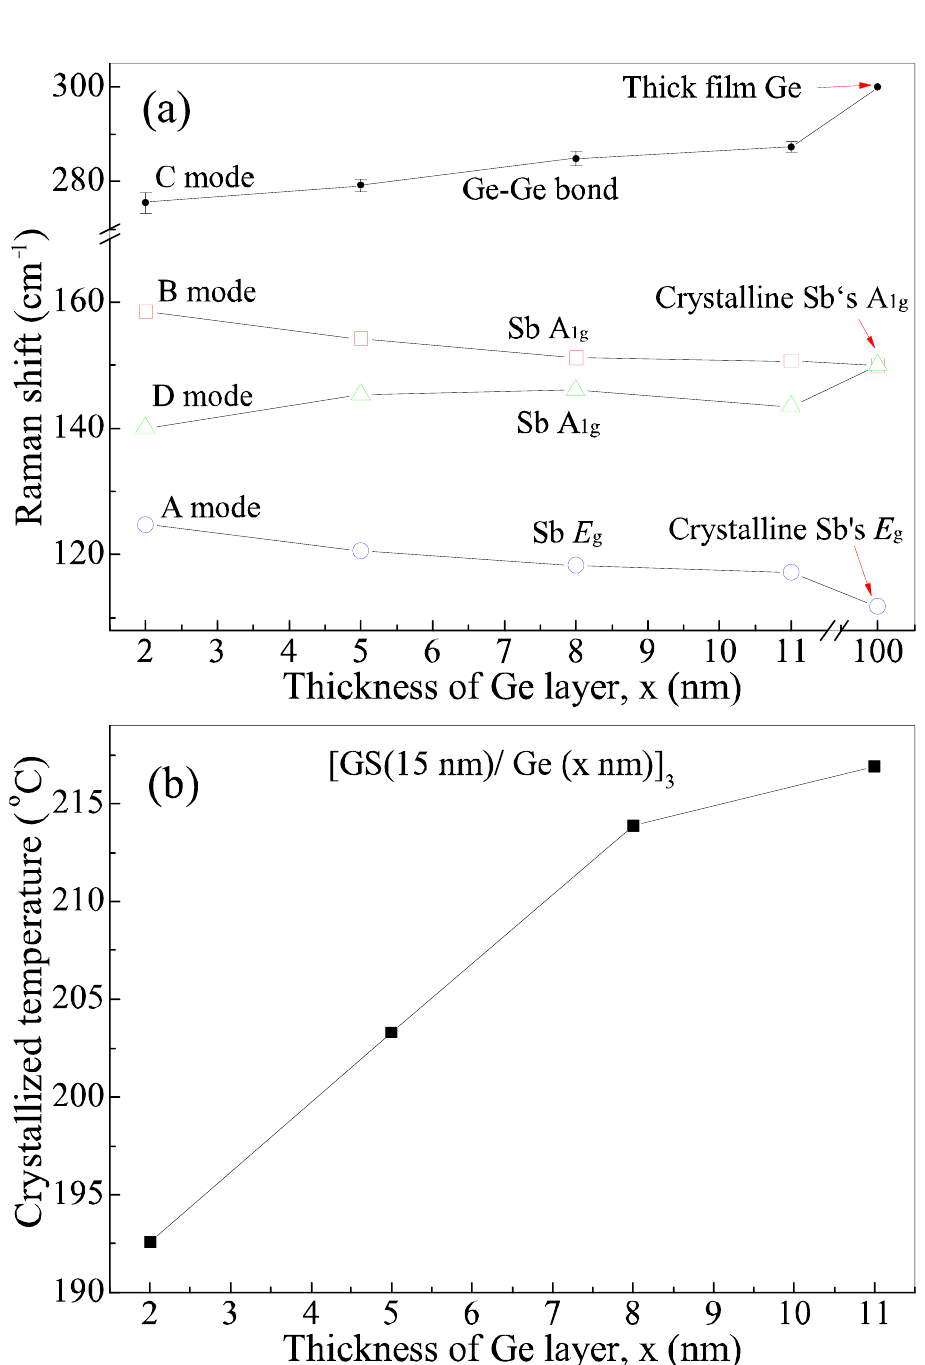
Figure 6. Variation in vibration frequency of various phonon modes ( a ) and crystallization tempera- ture ( b ) with x in SLL [Ge 8 Sb 92 /Ge(x m)] 3